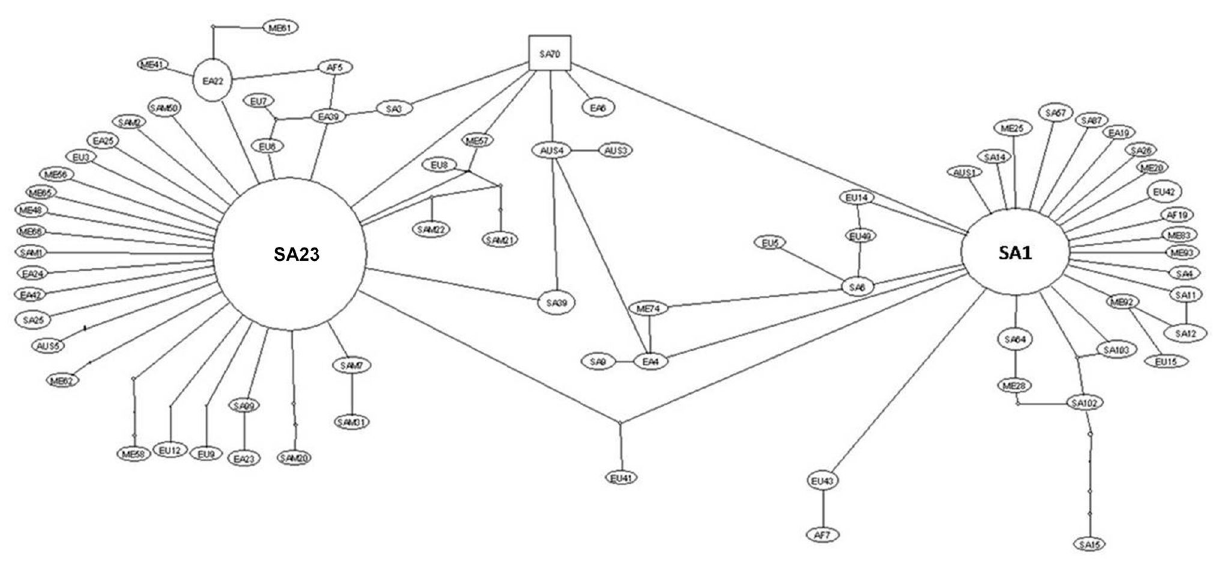
Figure 2. Haplotype network of cox1 gene of Echinococcus granulosus sensu stricto complex. Major circles represent predominant haplotypes. A branch represents a single nucleotide change and dots on branches represent inferred missing haplotypes. SA: South America; EA: East America; EU: Europe; ME: Middle East; AF: Africa; SAM: South America; AUS: Australia.